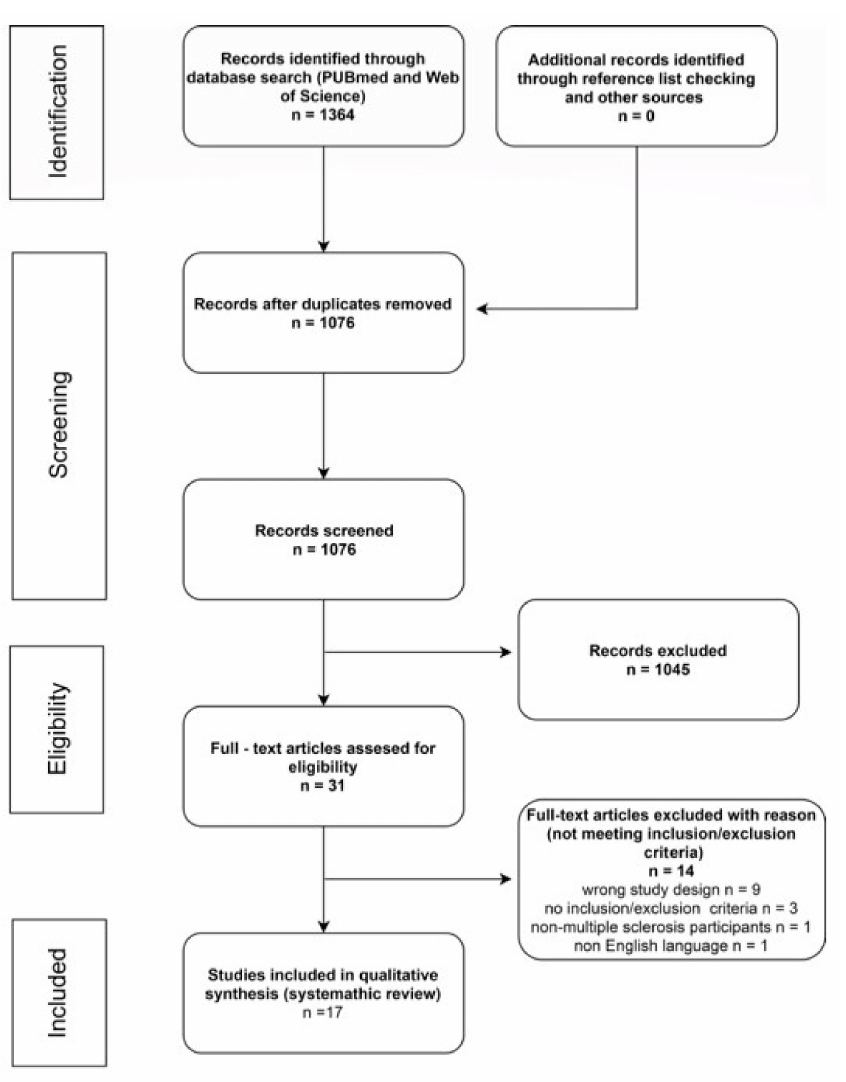
Figure 1. Study flow